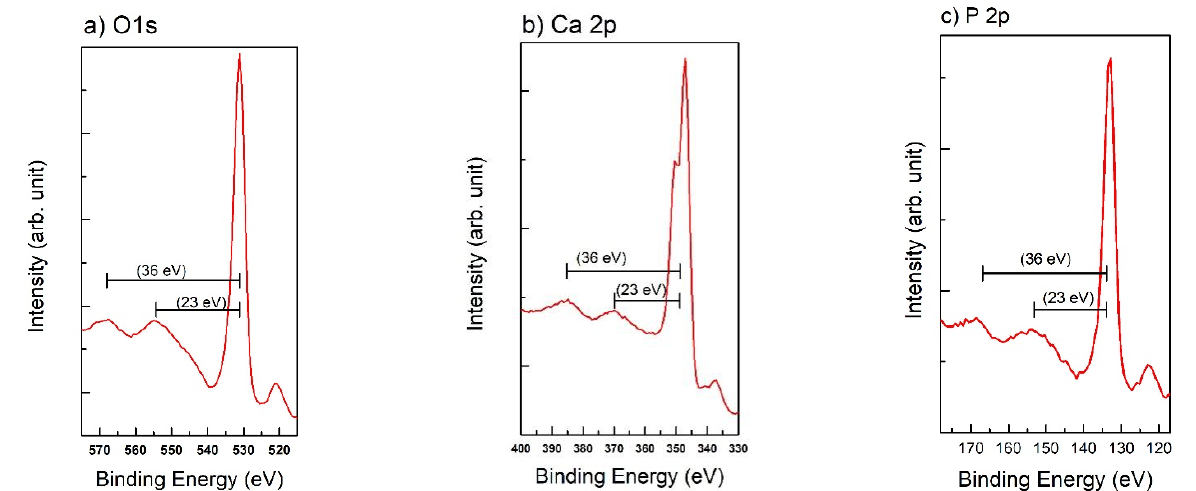
Figure 4. XPS spectra of O 1s ( a ), Ca 2p ( b ), and P 2p ( c ) regions. Besides the main photoemission peaks, in all the spectra are clearly visible the shake-up satellites.